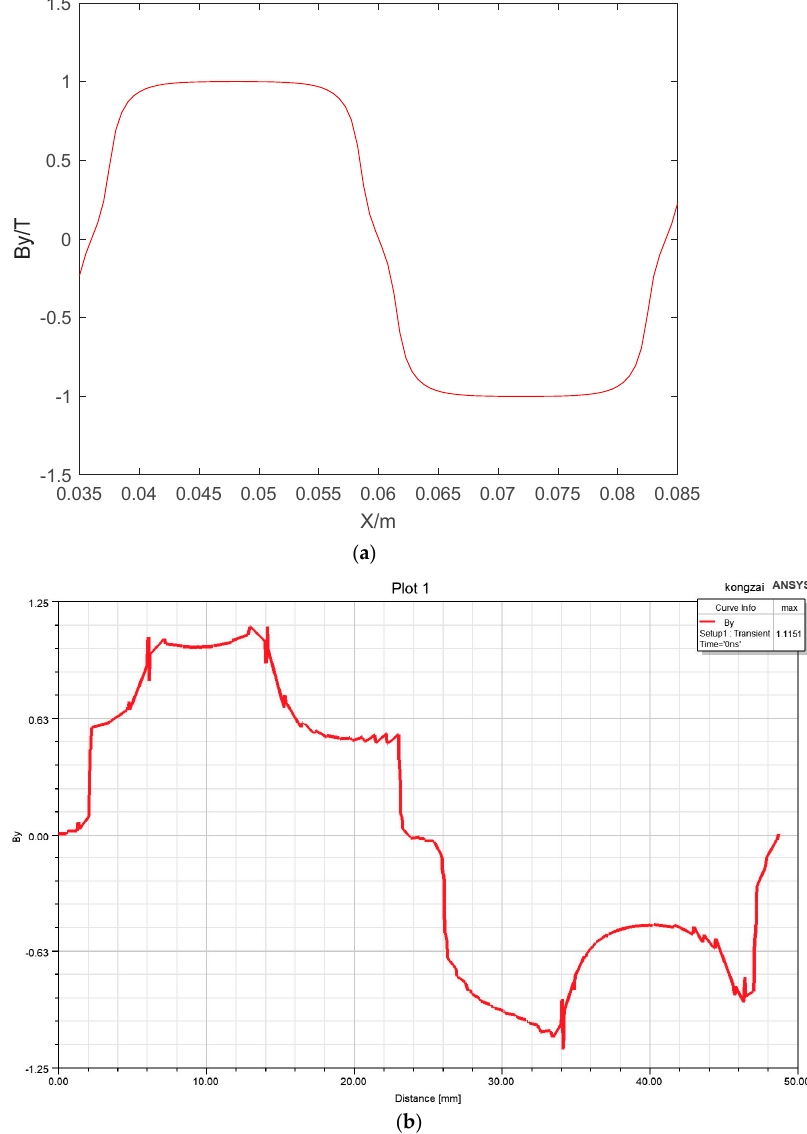
Figure 9. No − load air gap magnetic flux density distribution curve ( a ) No-load method calculates Figure 9. No-load air gap magnetic flux density distribution curve: ( a ) No-load method calculates the solution results for magnetic flux density theory ( b ) The result of the no-load method is to solve the solution results for magnetic flux density theory; ( b ) The result of the no-load method is to solve the finite element of magnetic flux density. the finite element of magnetic flux